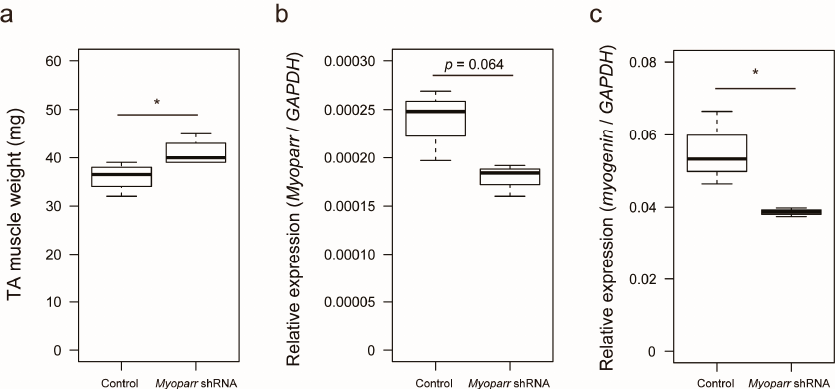
Figure 1. Knockdown of Myoparr attenuated skeletal muscle atrophy caused by denervation. ( a ) Box-and-whisker plots showing the weights of denervated tibialis anterior (TA) muscles of C57BL/6J mice electroporated with either control short hairpin RNA (shRNA) against Lac Z or Myoparr -specific shRNA. TA muscle weights were measured 3 days post denervation ( n = 4 per group). * p < 0.05, unpaired two-tailed Student's t-test. Central black bar indicates median; lower and upper box limits are 25th and 75th percentiles, respectively; whiskers show maximum and minimum values. ( b ) The level of Myoparr expression in denervated TA muscles electroporated either with control or Myoparr shRNA ( n = 3 per group) was measured by quantitative reverse transcription polymerase chain reaction (qRT–PCR). p = 0.064, unpaired two-tailed Student's t-test. Data were normalized to glyceraldehyde-3-phosphate dehydrogenase ( GAPDH) expression. ( c ) Quantitative reverse transcription–polymerase chain reaction (qRT–PCR) showing decreased myogenin expression by Myoparr knockdown 3 d post denervation ( n = 3 per group). * p < 0.05, unpaired two-tailed Student's t-test. Data were normalized to GAPDH expression.